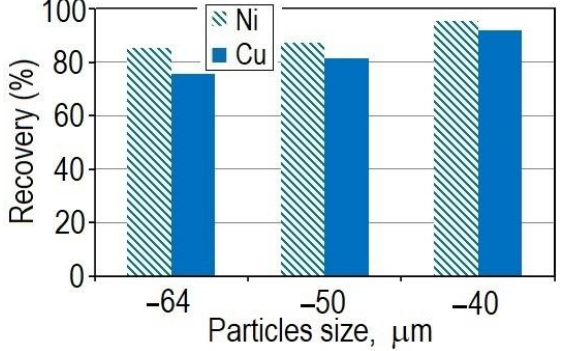
Figure 9. Recovery of metals into solution depending on the concentrate to ammonium sulfate mass ratio at a roasting temperature of 400 °C.